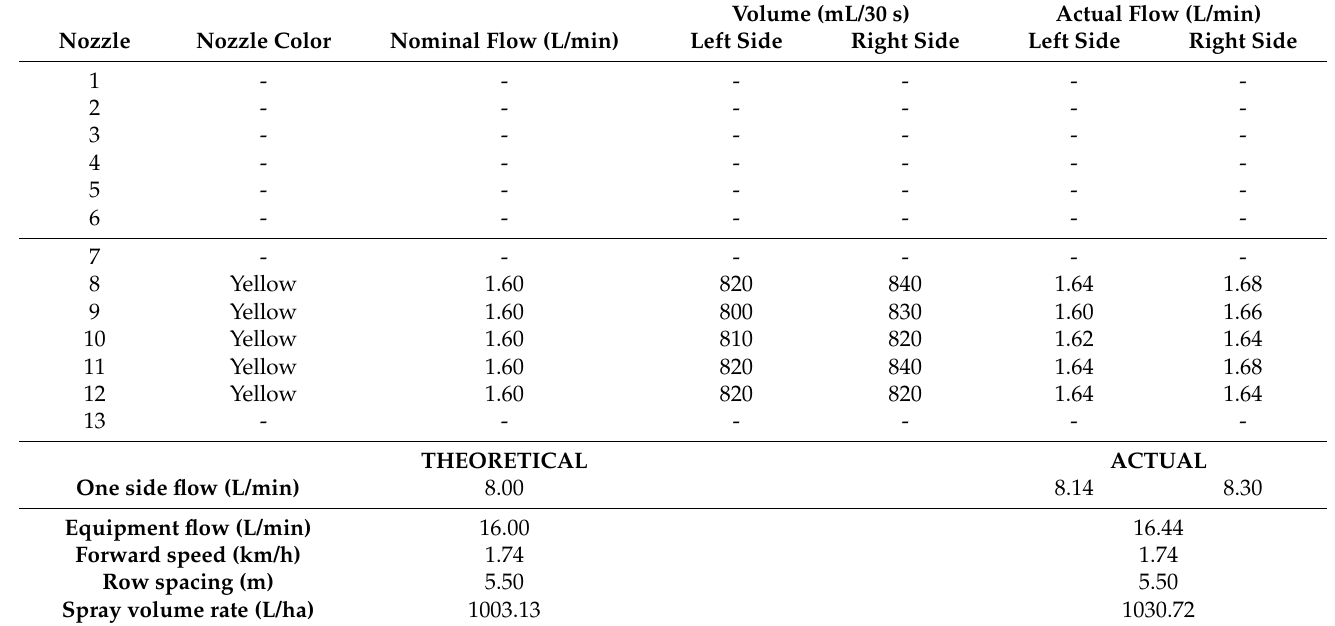
Table A21. Selection and calibration of nozzles for the C1 sprayer, with the following configuration: Adjusted to the vegetation/High & Low fan speed/Low spray volume rate/Drift-reducing nozzles (Coarse)/Pressure: 12 bar.